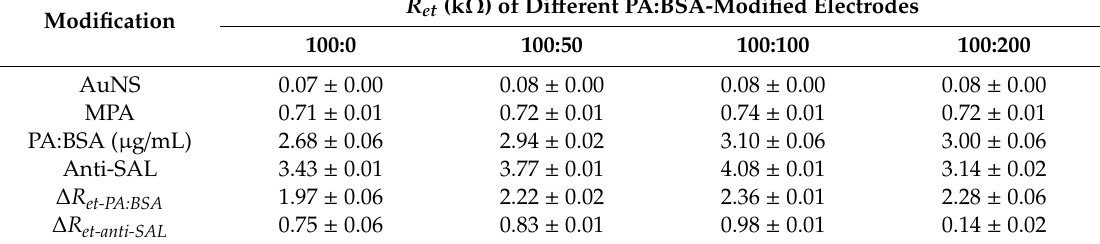
Table 1. Values of the R et element respectively fitted from the experimental spectra of Figuew 2a–d and the calculated ∆ R et-PA:BSA ( = R et-PA:BSA − R et-MPA ) and ∆ R et-anti-SAL ( = R et-anti-SAL − R et-PA:BSA ). ( n = 3) R et (k Ω ) of Di ff erent PA:BSA-Modified Modification